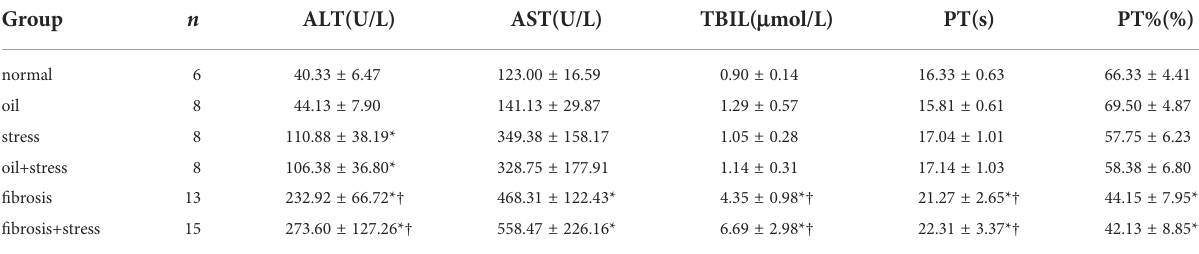
TABLE 2 Liver function and coagulation function of rats (means ± SD). Group